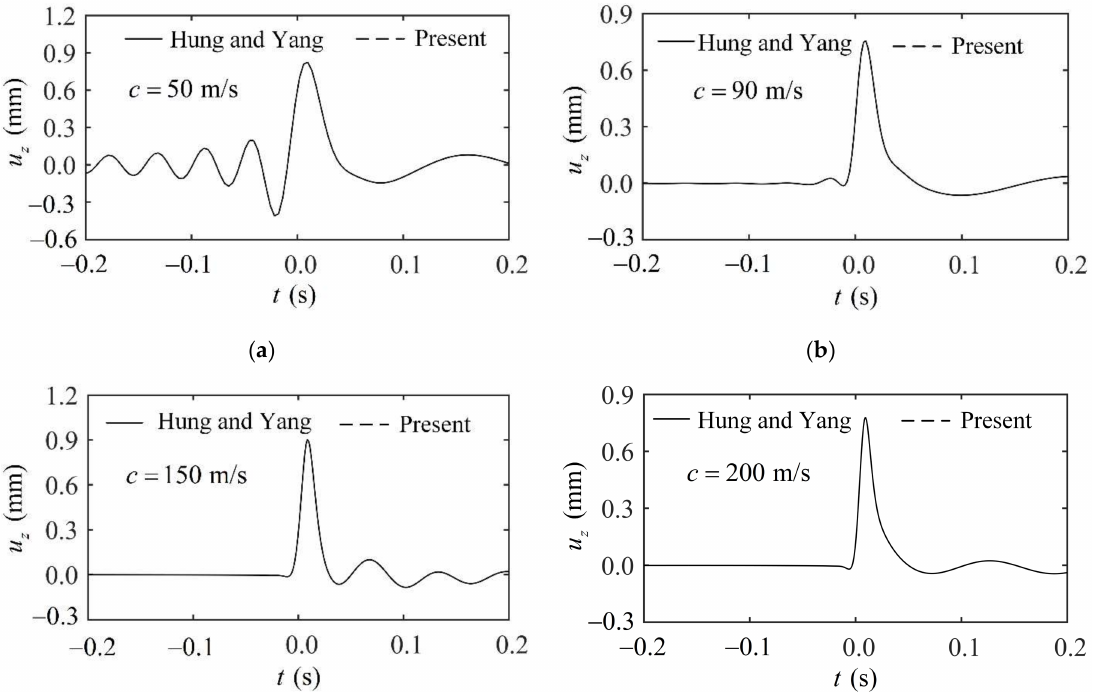
Figure 3. Comparison between the results for the proposed method and those in Hung and Yang